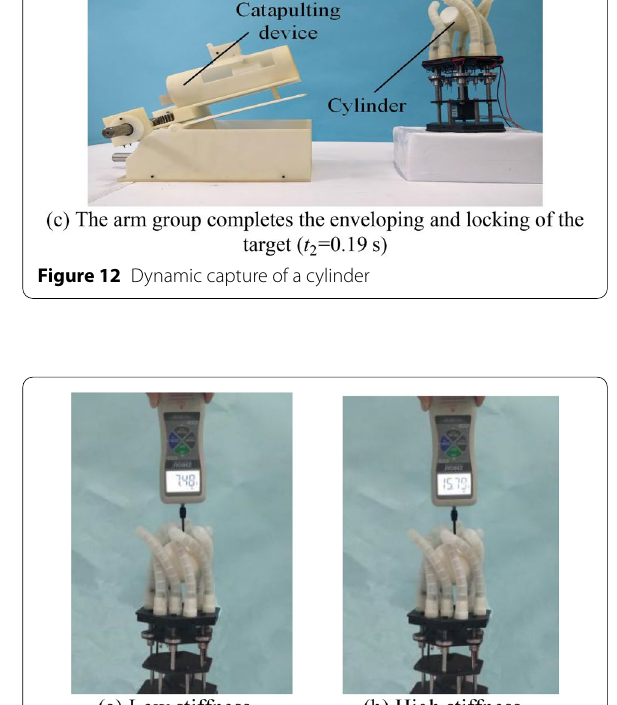
Figure 13 Verification of variable